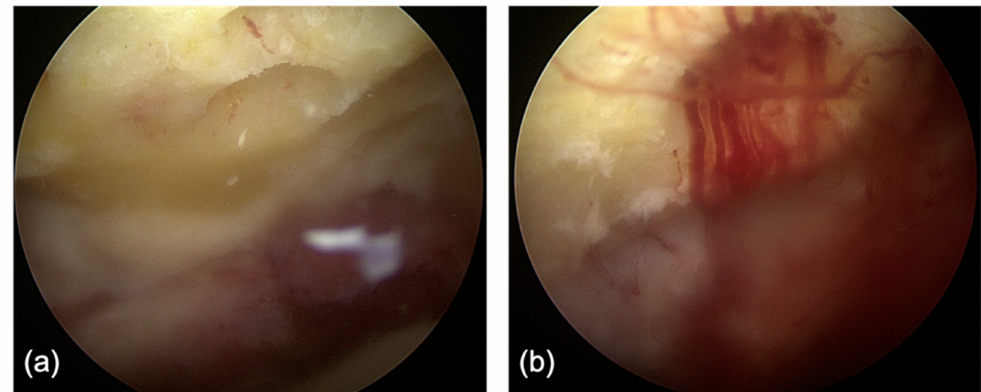
Figure 2. View from the anterolateral arthroscopic portal of a right ankle showing the fenestration of the subchondral bone on the tibial side ( a ) to induce stem cell ingress into the tibiotalar joint. The same view ( b ) after tourniquet removal, demonstrating bleeding